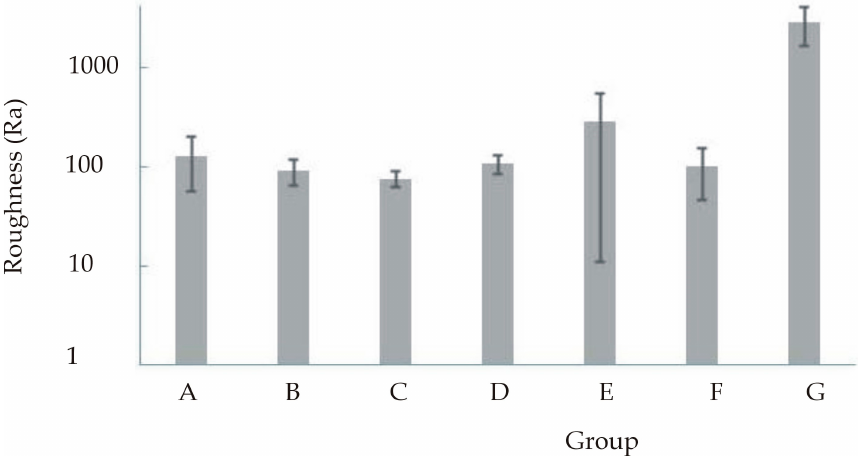
Figure 3. Mean value and standard deviation (logarithmised) for roughness (Ra).